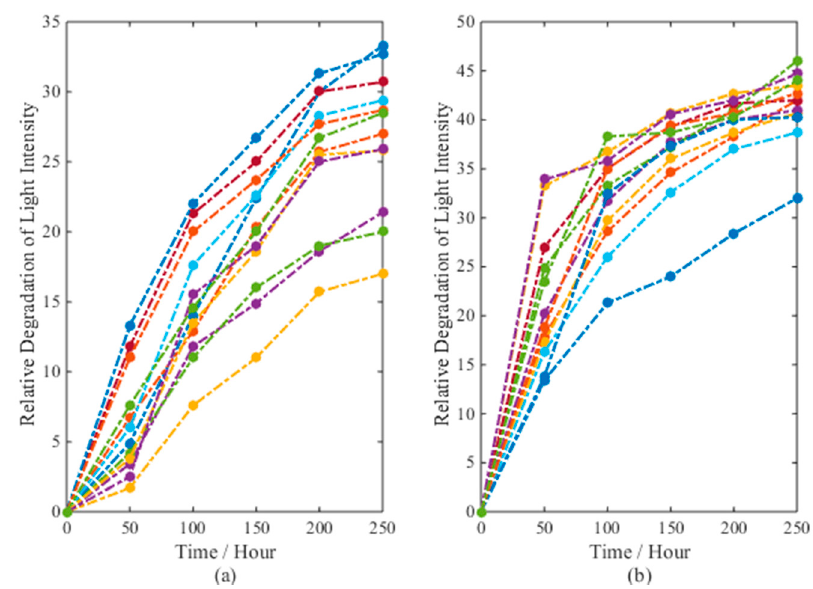
Figure 5. The degradation paths for twenty four LEDs under two electric current levels: ( a ) 35 mA and ( b ) 40 mA.